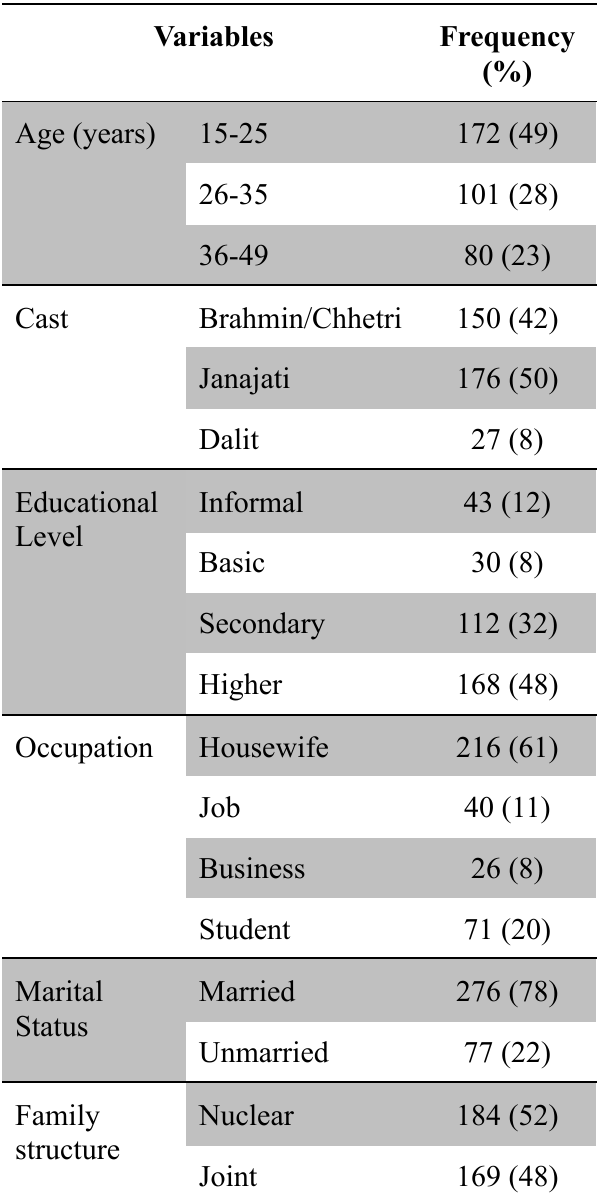
Table 1. Demographic profile of the respondents